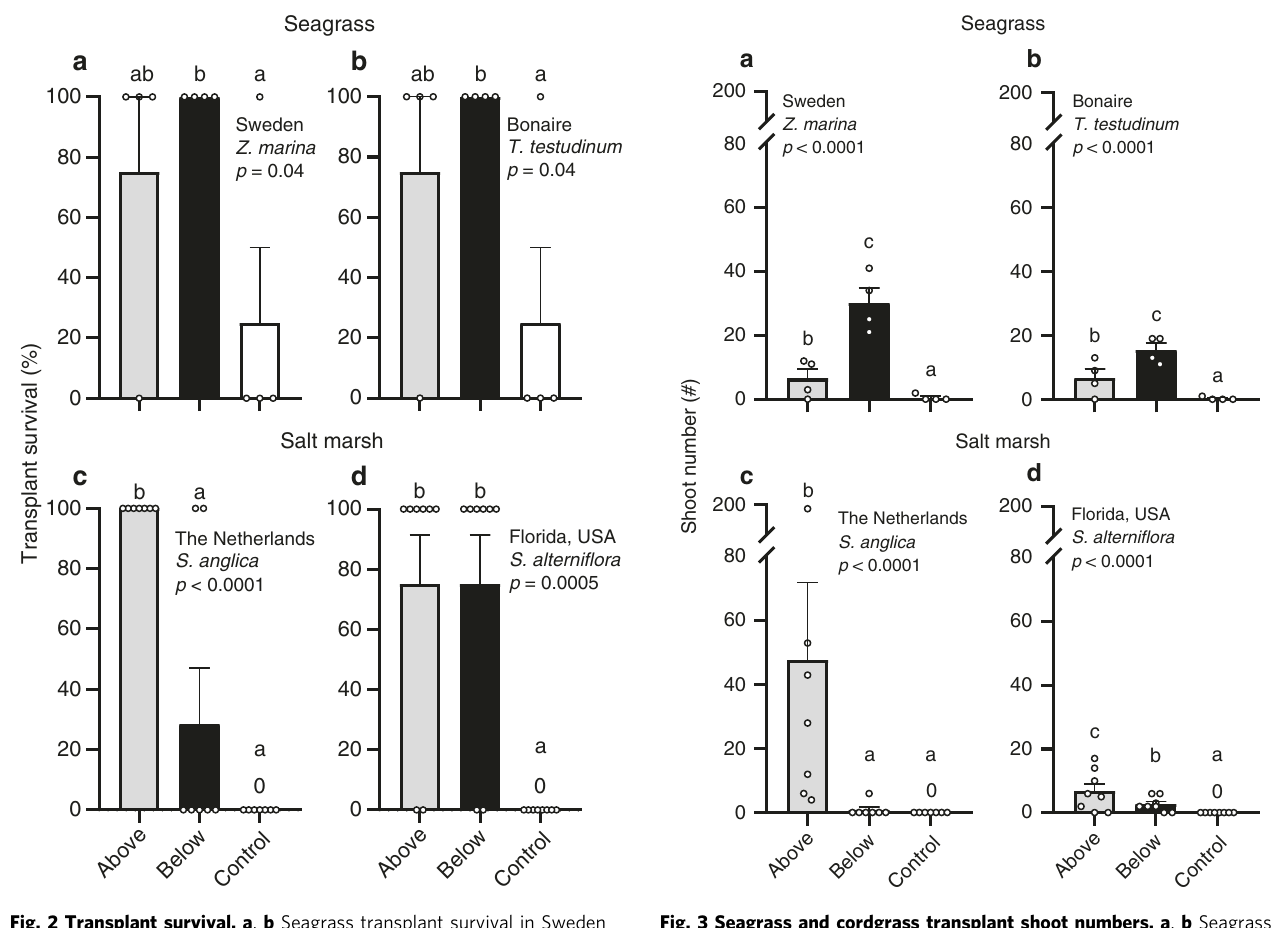
Fig. 3 Seagrass and cordgrass transplant shoot numbers. a , b Seagrass shoot counts in Sweden ( n = 4) and Bonaire ( n = 4) in above- (gray) and belowground structures (black), and controls (white). c , d Cordgrass shoot counts in the Netherlands ( n = 7) and Florida ( n = 8). Data are presented as mean values + SEM. Exact p values are shown for treatment effects when p > 0.0001 (two sided). Signi fi cant contrasts are indicated by different letters ( p < 0.05, Tukey corrections for multiple comparisons). Results of the statistical analyses are presented in Supplementary Table 3. Source data are provided as a Source Data fi